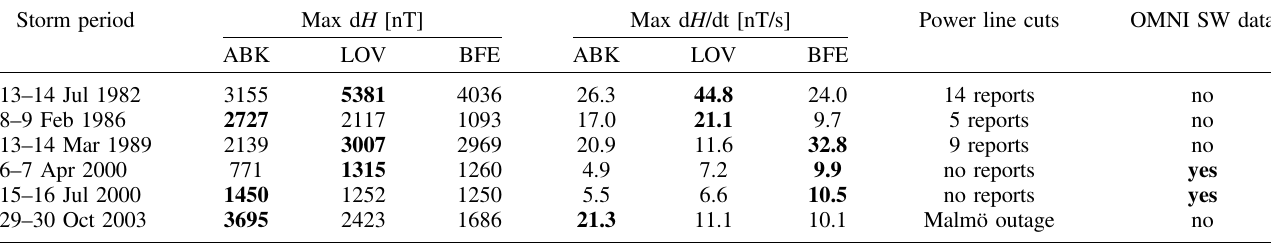
Table 1. List of examined magnetic storm intervals and maxima in H and d H /d t . Storm period Max d H [nT] Max d H /dt [nT/s] Power line cuts OMNI SW